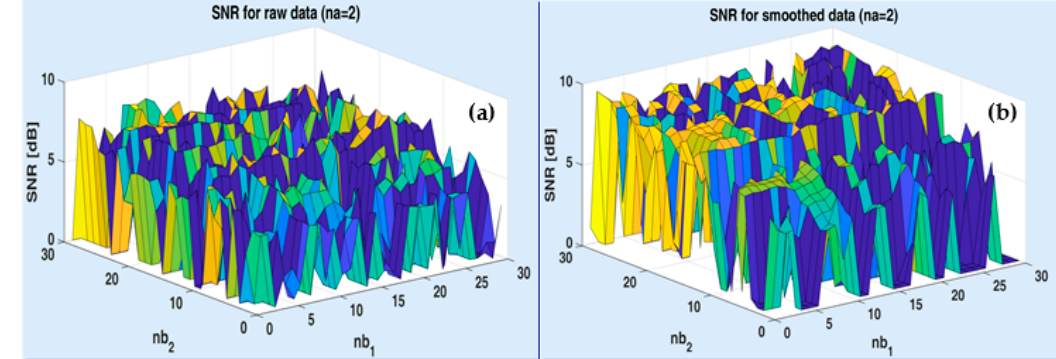
Figure 9. Examples of surfaces exhibited by signal-to-noise ration (SNR)-based criteria for raw output data ( a ) and smoothed data ( b ) on channel 1 of ASTANK2 installation.